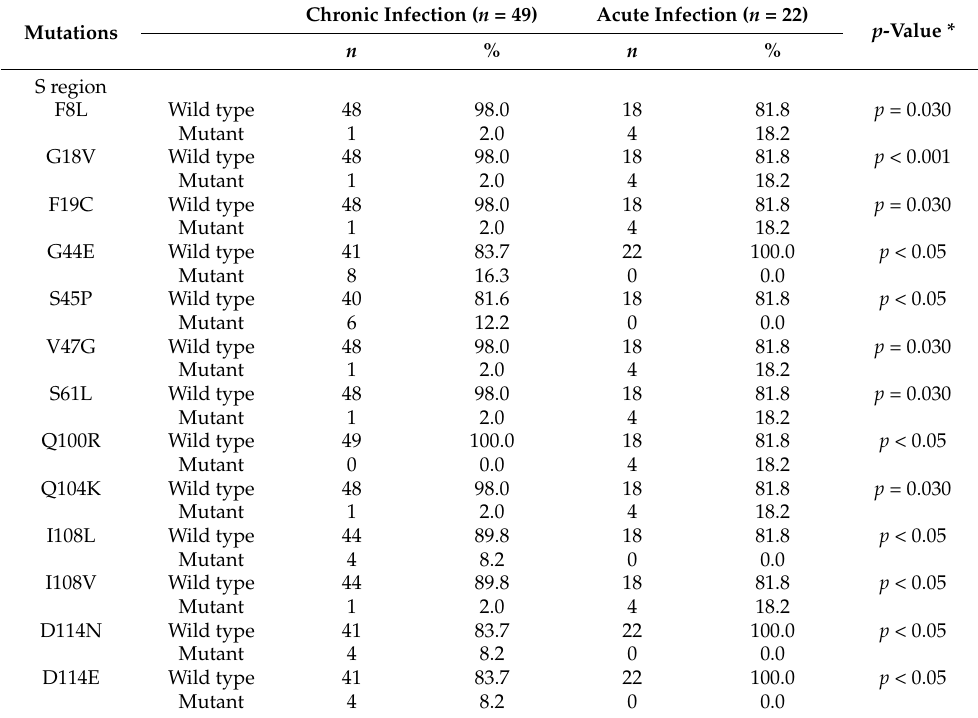
Table 5. Analysis of amino acid substitution in the S